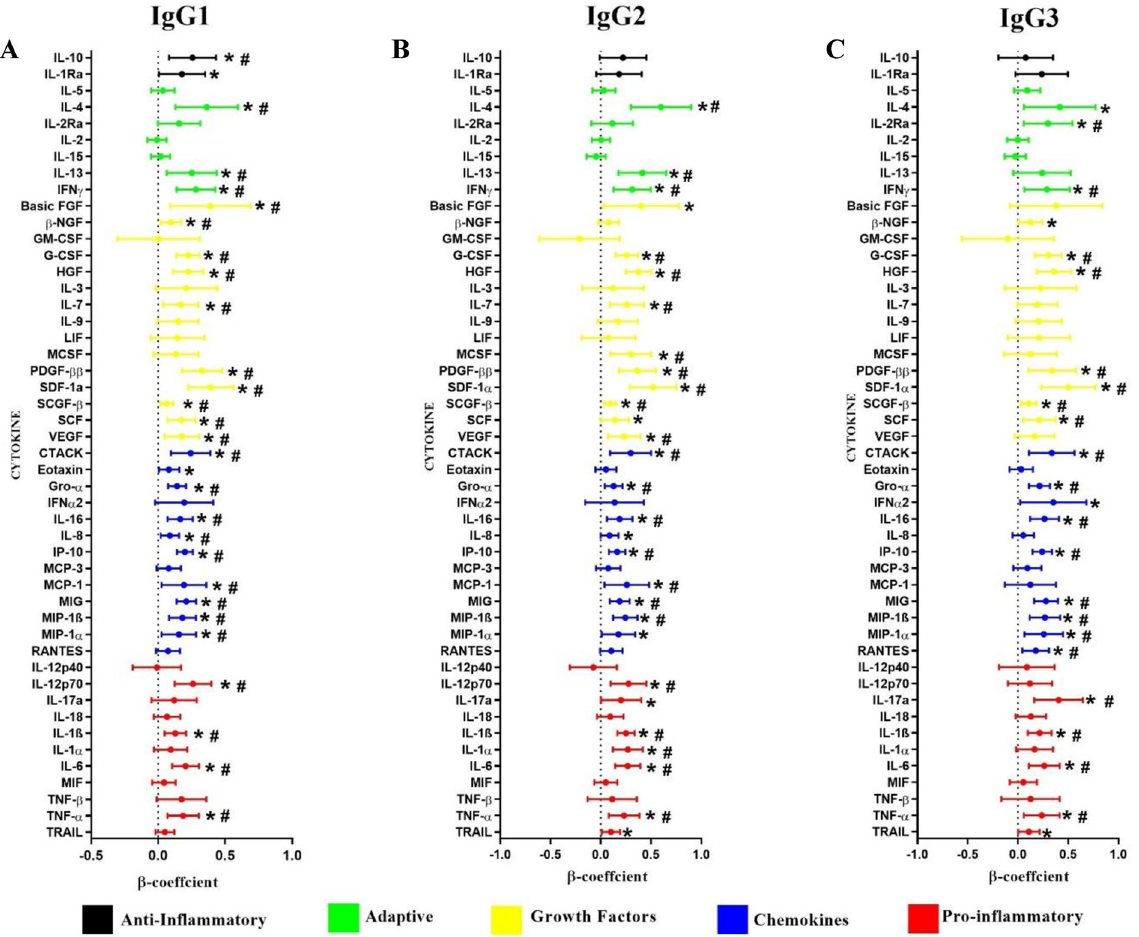
Figure 3. Associations between genital cytokines and mucosal IgG1 ( A ), IgG2 ( B ), IgG3 ( C ), IgG4 ( D ), IgM ( E ) and IgA ( F ). β-coefficients and p-values were determined using multivariable linear mixed models with a random effect of the matched pairs (N = 132). The multivariable models were adjusted for age, HSV-2 status, the number of vaginal sex acts, contraceptive method, condom use, tenofovir use and HIV infection status. β-coefficients are indicated by shaded circles and error bars indicate 95% confidence intervals. P -values < 0.05 are represented by *, and those p-values that are significant after multiple comparisons adjustment are represented by